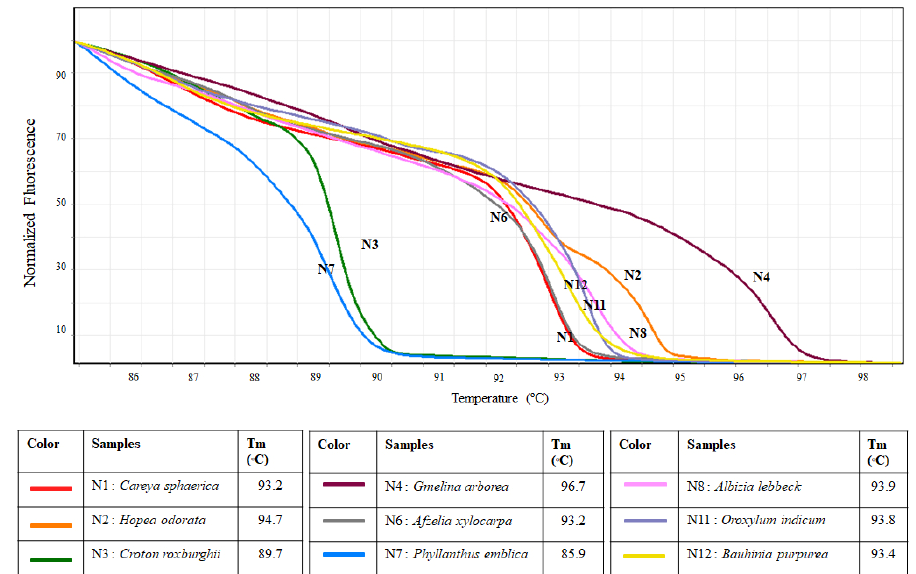
Figure 3. Melting profiles of nine tested species generated from HRM analysis using ITS